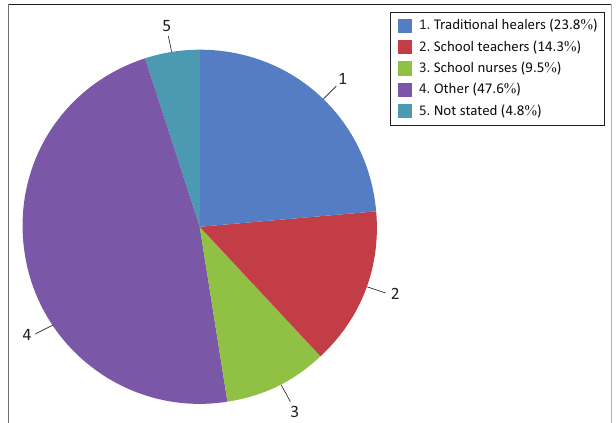
FIGURE 1: Percentage distribution of referrals to primary healthcare nurses.